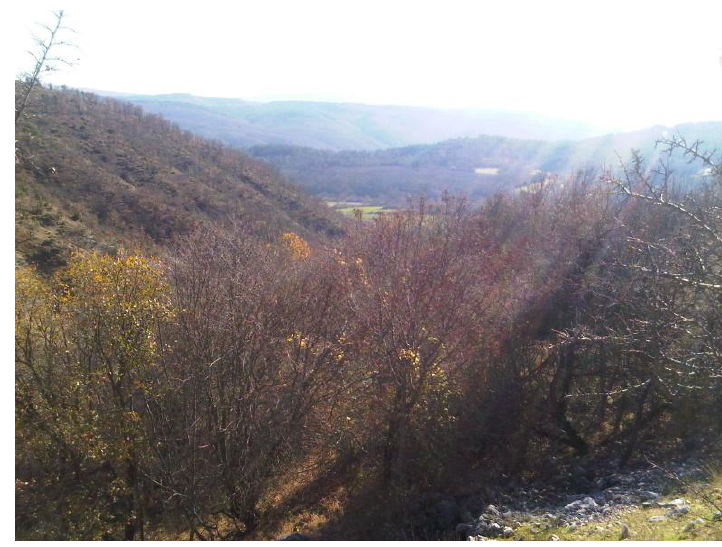
Figure 7. Forest area in front of the Mikro Derio quarry.